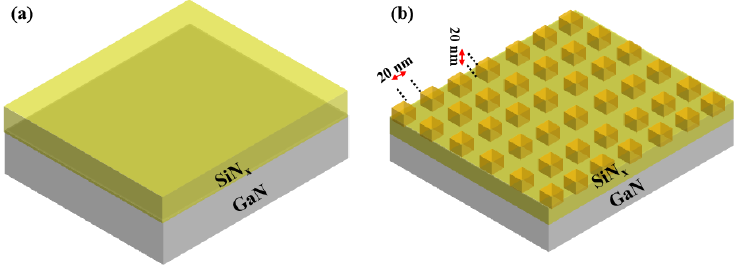
Figure 1. Schematic of the GaN/SiN x , ( a ) Original structure, ( b ) Periodic structure.